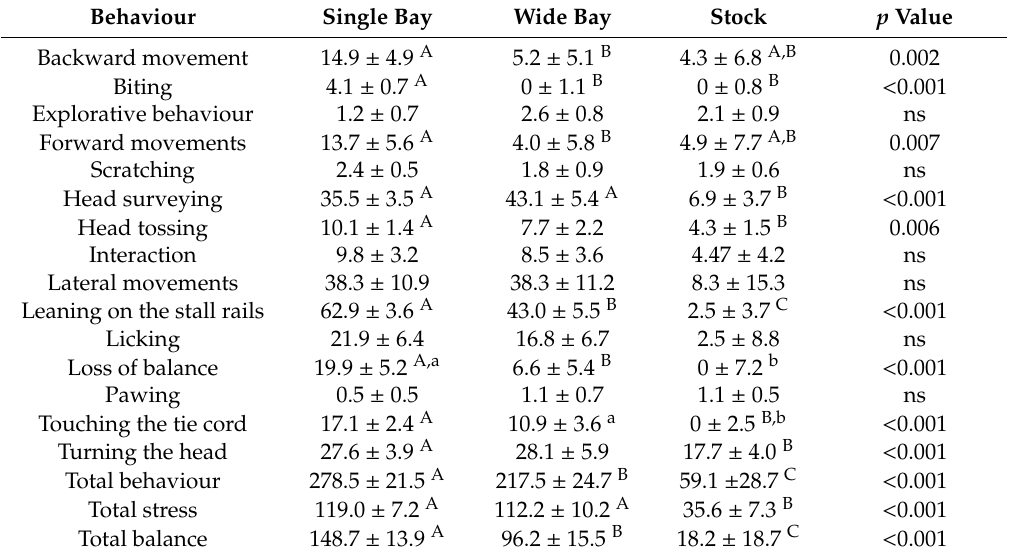
Table 2. E ff ect of space (stocks, single or wide bays) on the studied behaviours. Data are expressed as the least square mean and standard error (SE) of the number of observed behavioural events, with p -value determined by linear mixed model and Tukey post-hoc testing. Means with di ff erent superscript di ff er significantly (A, B, C, p < 0.01; a, b, p <